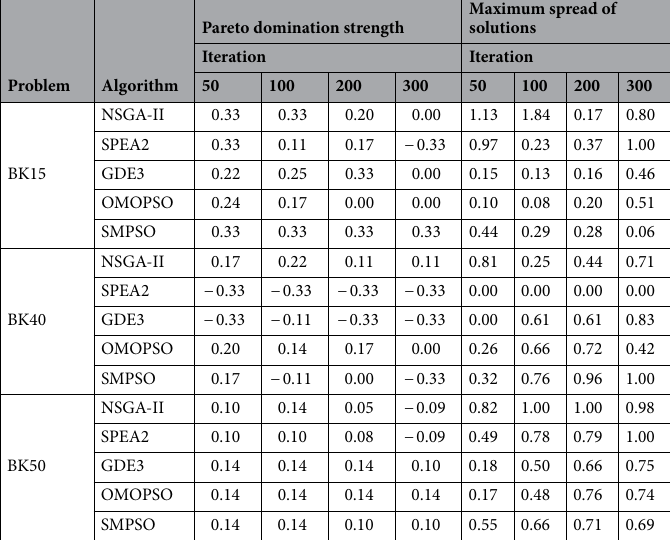
Table 4. Calculated Pareto domination strength and maximum spread of solutions in front for algorithms.